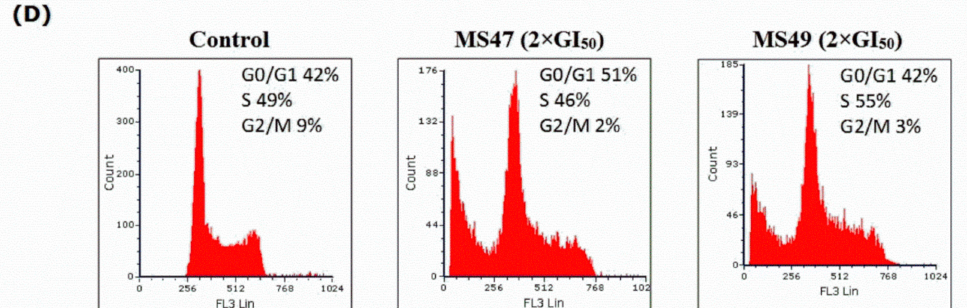
Figure 6. Statistical analyses of cell cycle phases: G0/G1, S and G2/M in human melanoma MDA- MB-435 cells, treated with 0.5 × GI 50 , 1 × GI 50 and 2 × GI 50 of MS47 and MS49 compared to the untreated cells (control group) for ( A ) 24 h, ( B ) 48 h and ( C ) 72 h. MS47 (2 × GI 50 ) evoked significant arrest in the G0/G1 and G2/M phases (* p < 0.05 and ** p < 0.005; experiments were repeated ≥ three times, n = 2). ( D ) Flow cytometric cell cycle analysis (histograms) of human melanoma MDA-MB-435 cells, treated with MS47 and MS49 of 2 × GI 50 concentrations for 72 h compared to the control cells and stained with propidium iodide